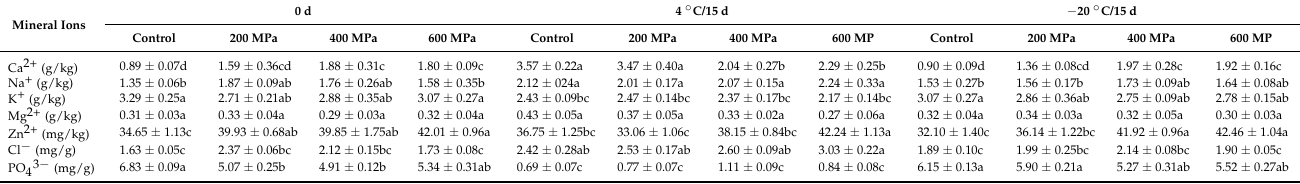
Table 5. The concentrations of mineral ions in red claw crayfish with different